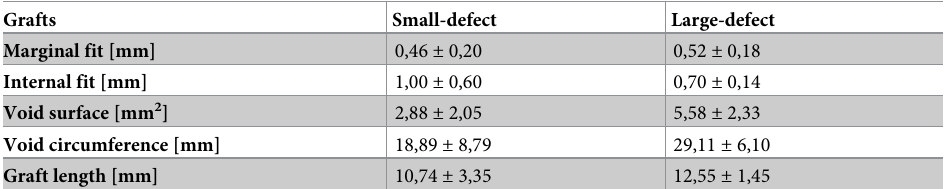
Table 3. Mean void-surface dimensions. Grafts Small-defect Marginal fit [mm] Void surface [mm 2 ] Void circumference [mm] Graft length [mm] 10,74 ± 3,35 12,55 ± 1,45 The marginal fit in both groups was significantly lower than the internal fit (P = 0.00). Statistically significant difference was found between the lengths of the grafts in both groups (P = 0.013). For the analysis each alveolar ridge model was fitted with three grafts of same design and each graft was measured in triplicate, n = 18, P < 0.05 (independent t